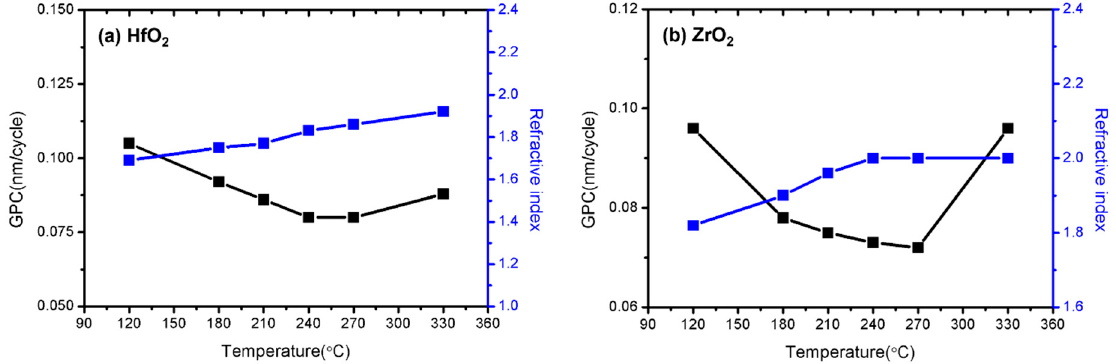
Figure 2. Changes in the GPC and refractive index of the ( a ) HfO 2 and ( b ) ZrO 2 single thin films deposited by RPALD, according to the deposition temperature.